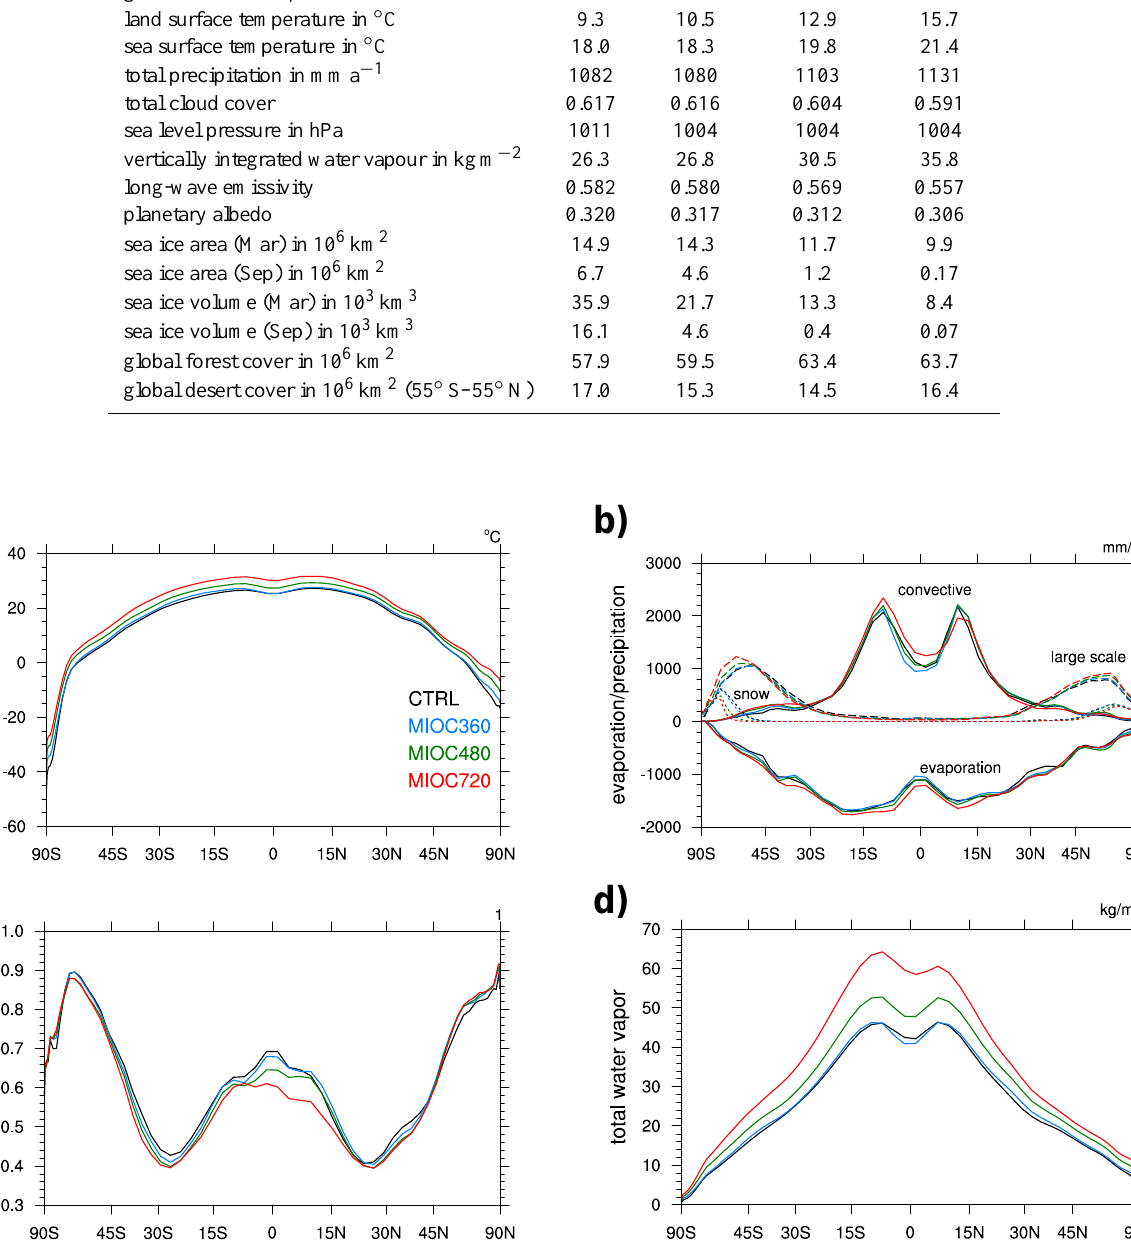
Fig. 2. (a) Zonally averaged 2m air temperature (in ◦ C). (b) Zonally averaged convective precipitation, large-scale precipitation, snow fall, and evaporation (in mma − 1 ). (c) Zonally averaged cloud cover. (d) Zonally averaged total water vapour content of the atmosphere (in kgm − 2